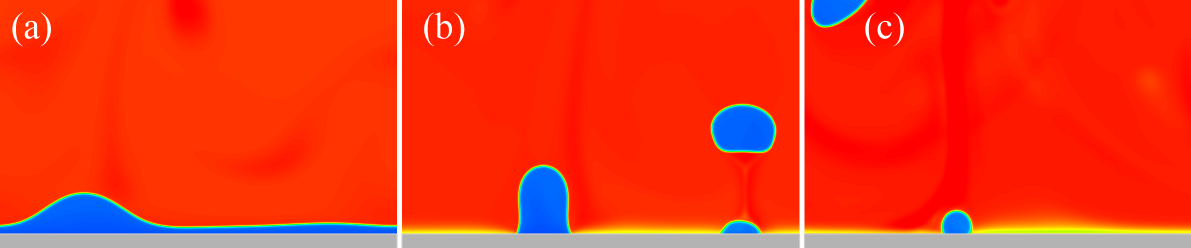
Figure 4. The density contour plots illustrating the boiling process at moderate surface superheat, Δ T = 0.06 T c . ( a ) lyophobic surface ( θ = 116°), ( b ) neutral surface ( θ = 90°) ( c ) lyophilic surface ( θ = 38°).